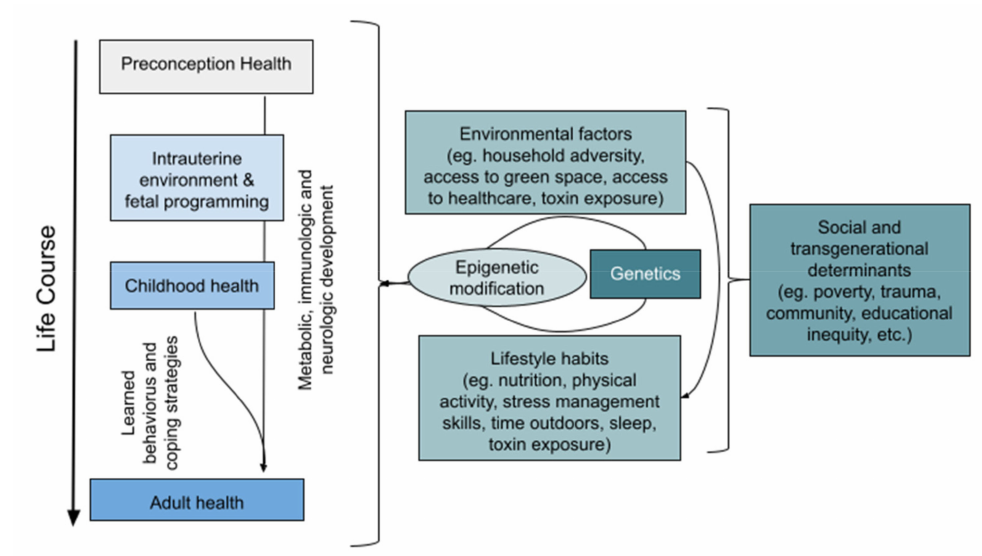
Figure 2. Many factors are established early in life that affect adult health outcomes. Some factors are modifiable, such as lifestyle habits and social behaviours. Others are pre-determined (but may be modifiable) such as preconception health, genetics, and transgenerational behaviour patterns. (courtesy of author, informed by references